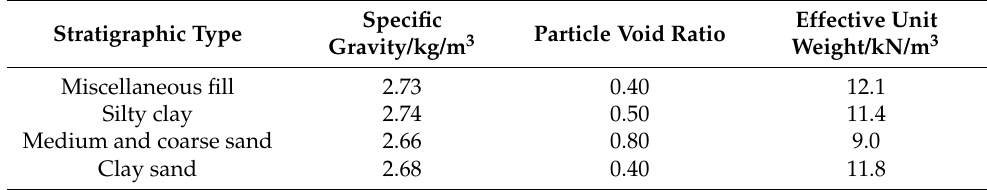
Table 3. Laboratory test results of different